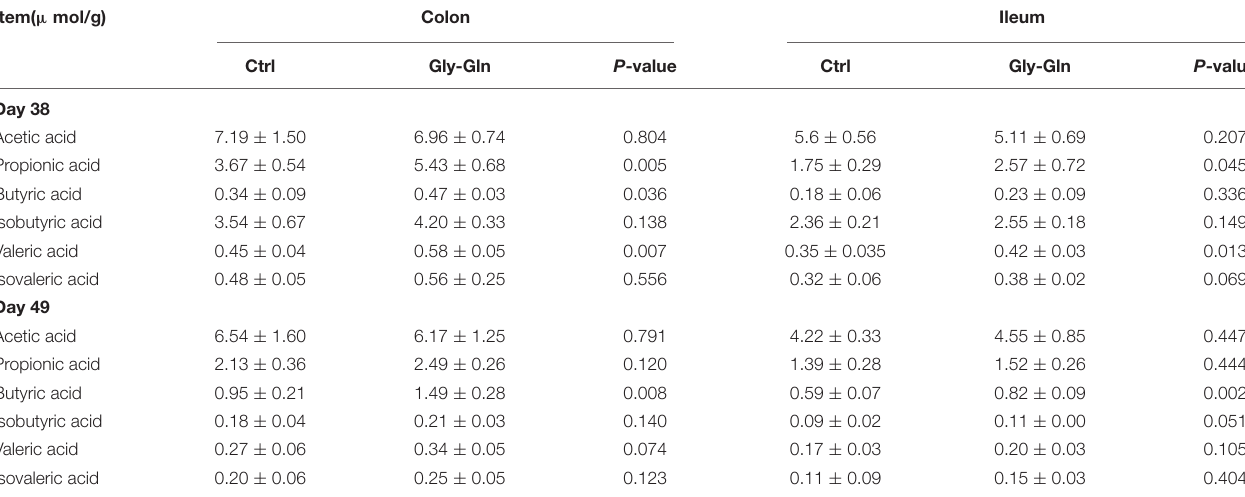
TABLE 1 | The concentration of SCFAs in the digesta of colon and ileum.